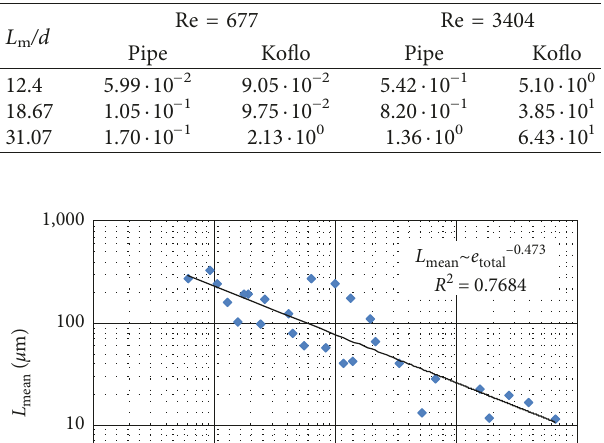
Table 9: The collection of the total destruction